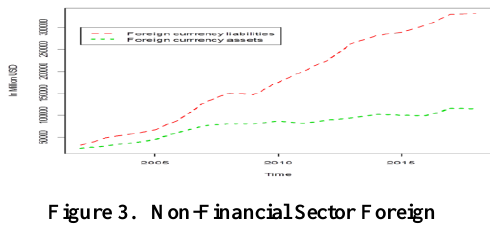
Figure 2. Non-Financial Firms’ Financial Debt Ratios Source: CBRT, 2018